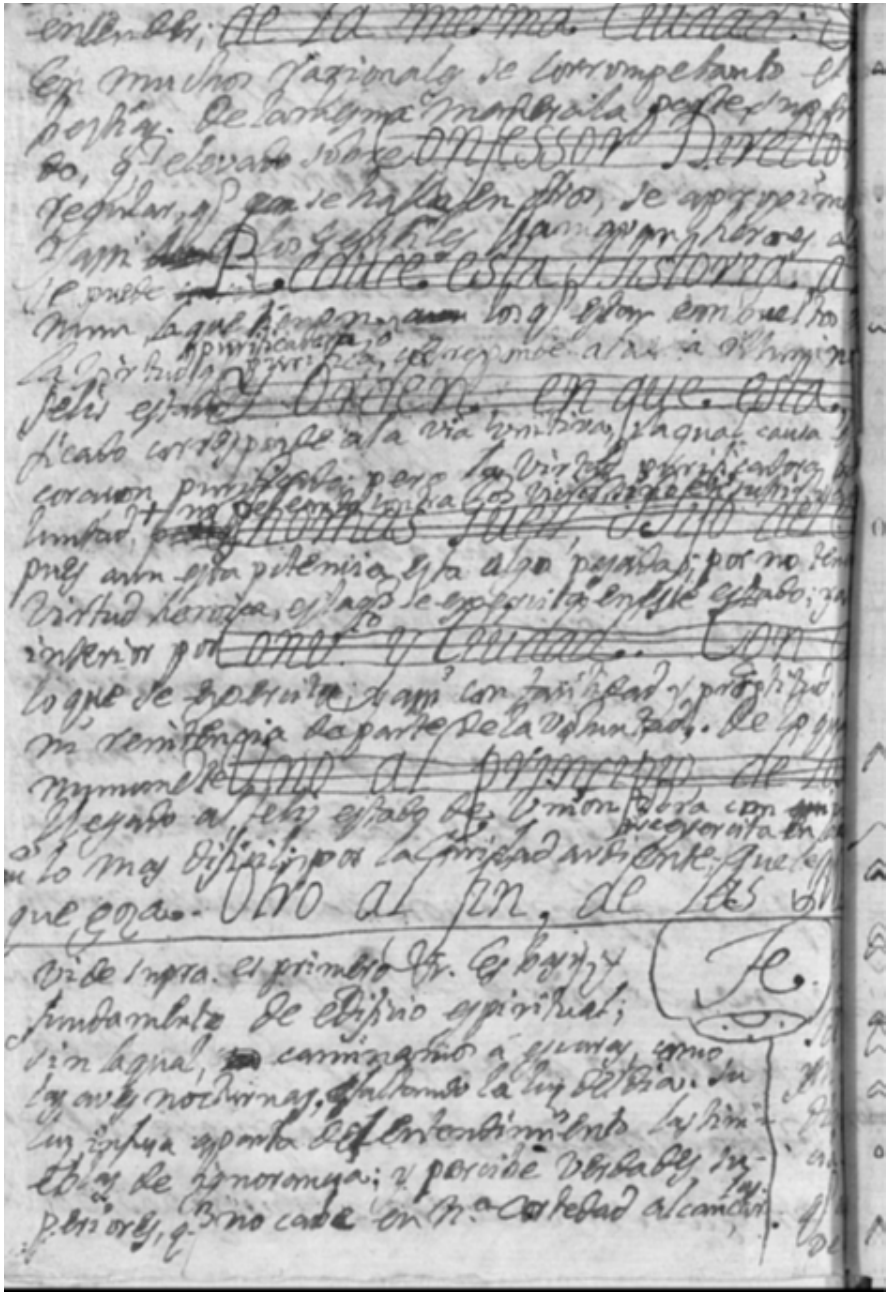
Figure 3. Folio from the Vida of María de Ortola.